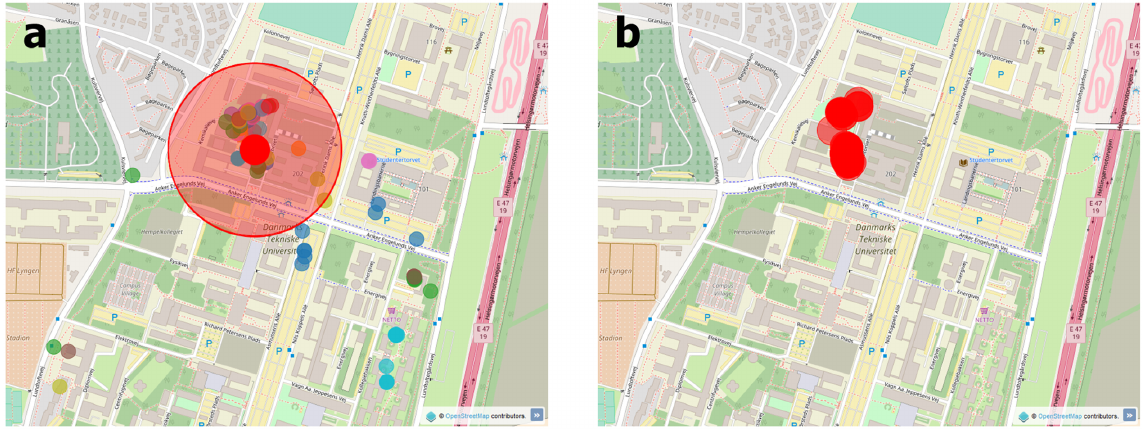
Fig 1. Estimation of class locations at the Technical University of Denmarkcampus. a) Locationof the students who were assignedto a specific class (coloredsmall circles), with the estimated location(moderate size red circle) and range of the class (large light red circle) in a particular day. b) Estimated class locations(red circles) of the same course throughoutthe semester. (Map data copyrighted OpenStreetMap contributorsand availablefrom www.openstreetmap.org under CC BY-SA 2.0).